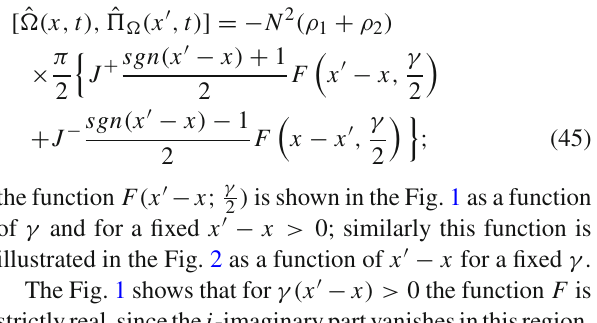
strictlyreal,sincethe i